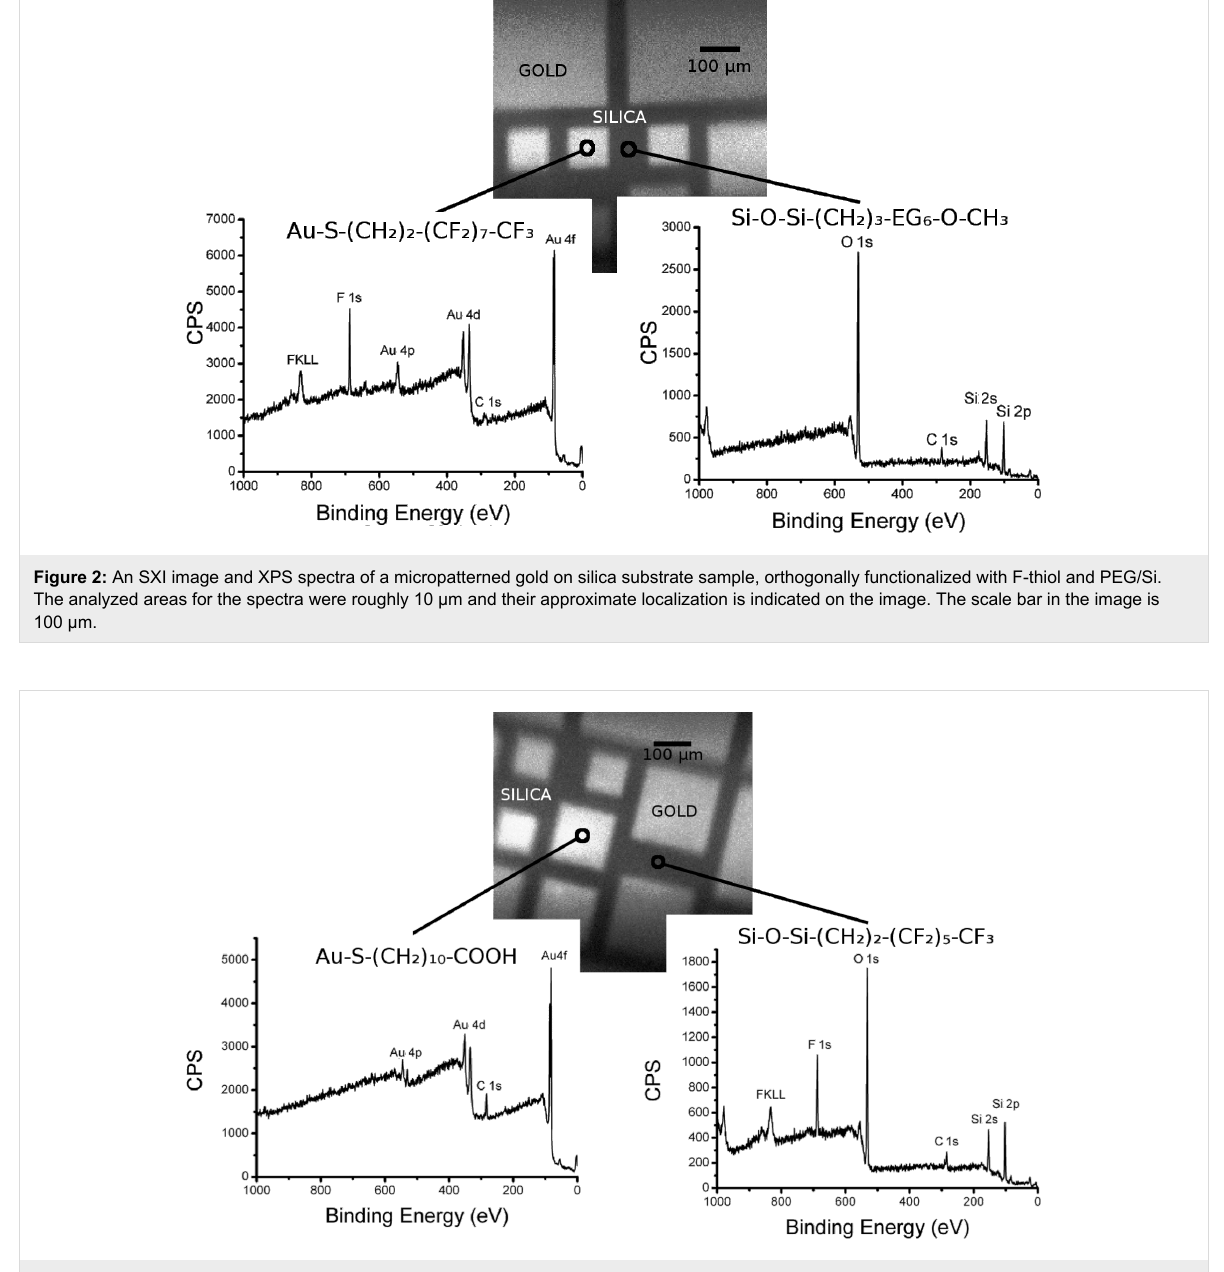
Figure 3: An SXI image and XPS spectra of a micropatterned gold on silica substrate sample, orthogonally functionalized with MUA and F-silane. The analyzed areas for the spectra were roughly 10 µm and their approximate localization is indicated on the image. The scale bar in the image is 100